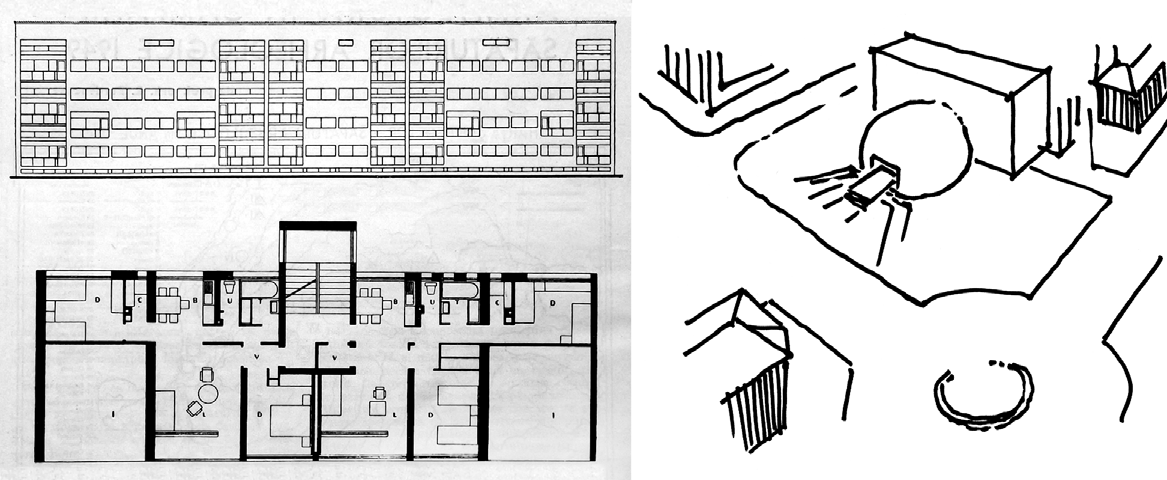
fig. 2. left – Virgil niţulescu’s project. right – the architect’s project for the national opera. My sketch after a drawing by Ion M. Enescu. Sources : Arhitectura , 1950, 2–3: 75; Enescu 2006: